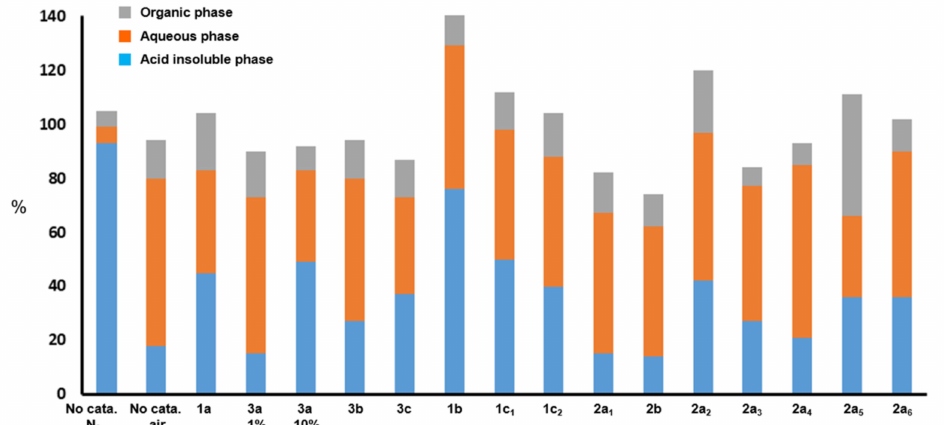
Figure 9. Influence of the catalysts on the fractionation of the reaction mixture after lignin depolymer- ization (150 ◦ C, pair 20 bar, 1 h, C lignin 5 g L − 1 , C NaOH 10 g L − 1 , and C M 0.05–0.5 g L − 1 [M = Pd or Au]); 1% refers to a mass of Pd corresponding to 1% wt of the lignin giving a Pd loading of 0.05 g L − 1 , and 10% refers to a mass of Pd corresponding to 10% wt of the lignin giving a Pd loading of 0.5 g L − 1 .